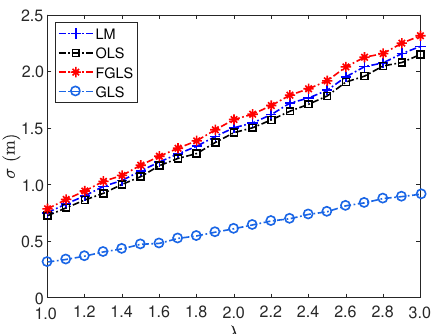
Fig. 2 Effects of measurement ranges with IID